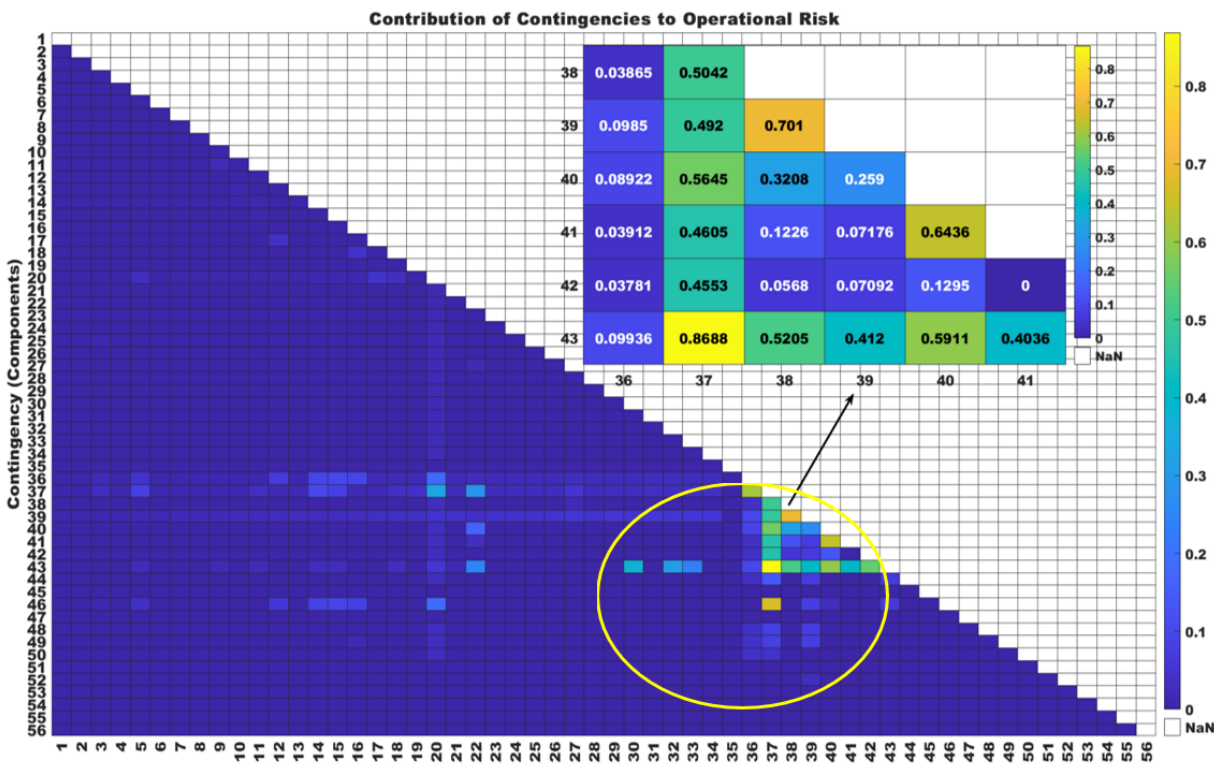
Figure 7. Contribution of contingencies towards ORUV (OS-1). The color scale indicates the contribution of each contingency (defined by Equation (8)), as quantified by the color bar on the right, in the relevant unit. The color scale is selected such that the lowest value is dark blue and the highest value is yellow.